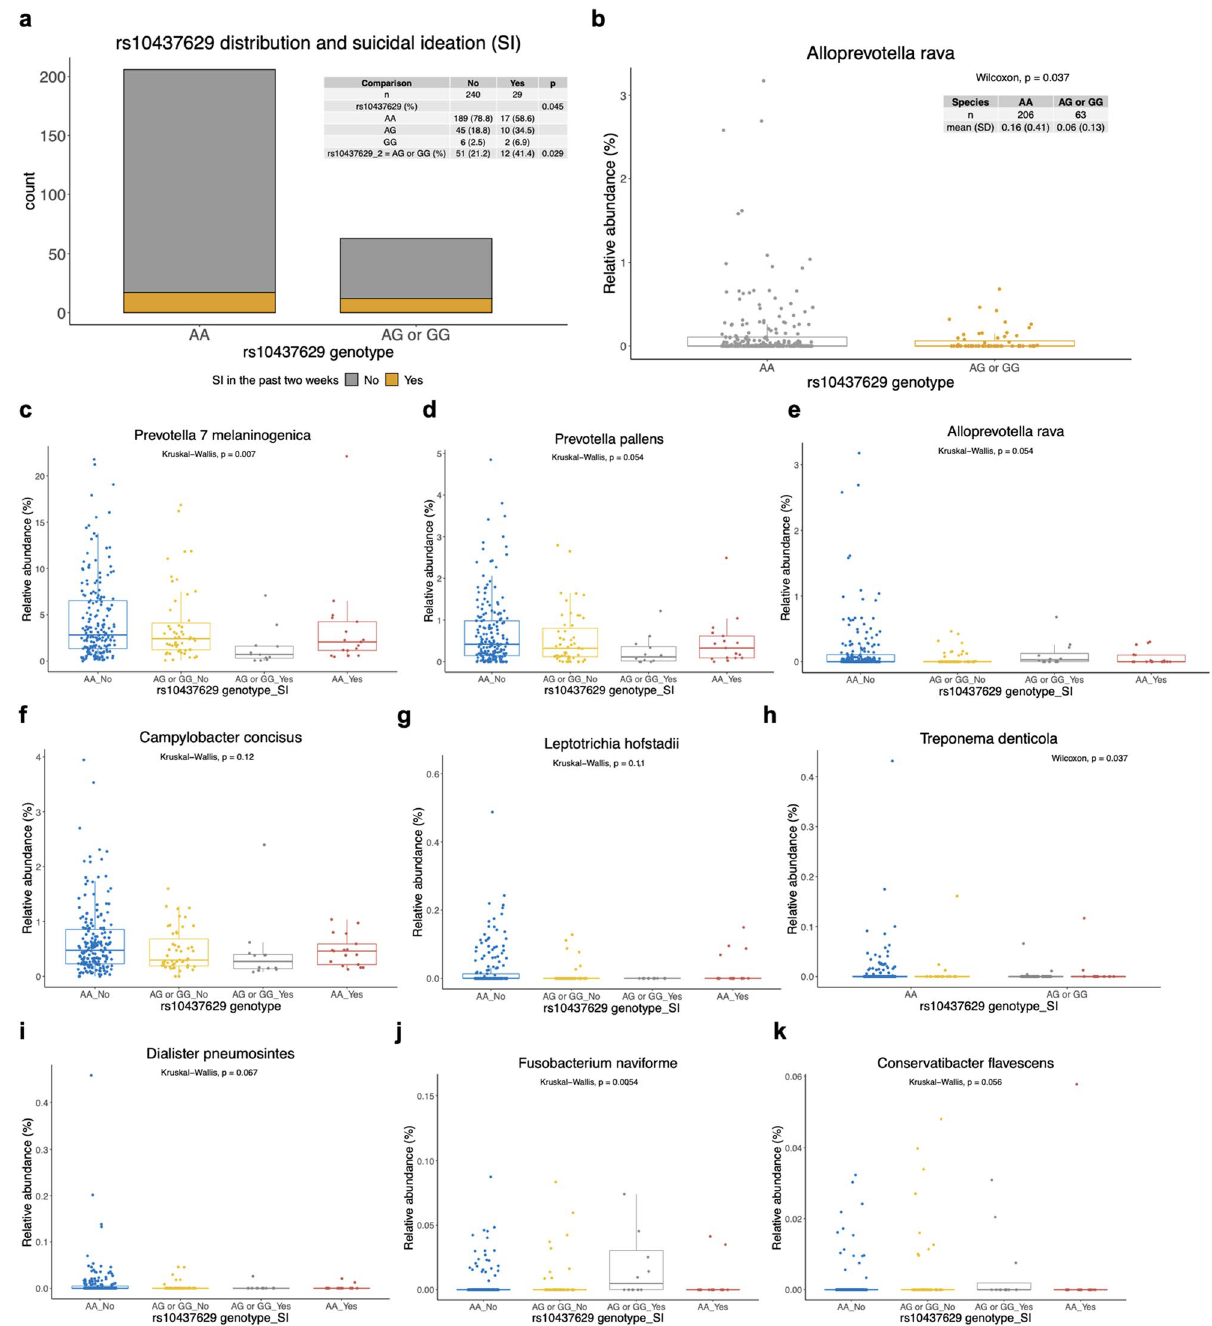
Figure 1. Interaction of rs10437629 genotype and endorsement of recent suicidal ideation (SI) with significantly associated saliva species. ( a ) Distribution of A and G alleles in rs10437629 (N = 269). ( b ) Relative abundance of Alloprevotella rava counts across genetic variants and SI, with a significant difference in abundances between individuals with AA and individuals with AG or GG, Wilcoxon p = 0.037. Here, two groups were compared (homozygotes AA versus heterozygotes, AG, or homozygotes, GG, for the minor G allele) with a Wilcoxon test. ( c – k ) Selected bacteria that were differentially abundant across rs10437629 genotype (AA vs. AG or GG) and endorsement of SI. For these associations, Kruskal–Wallis tests were performed against four separate genotype-SI combinations: (1) AA genotype and no SI (AA_No), (2) AG or GG genotype and no SI (AA or GG_No), (3) AG or GG and SI (AG or GG_Yes), and (4) AA genotype and SI (AA_Yes). In e, Alloprevotella rava is again presented but with this four-group comparison. For each four-group comparison, a Kruskal Wallis test was conducted; p values are presented within the plots. Species assignment was based on Silva taxonomy of the amplicon sequence variants (ASVs) and included all ASVs that were mapped to that closest cultured